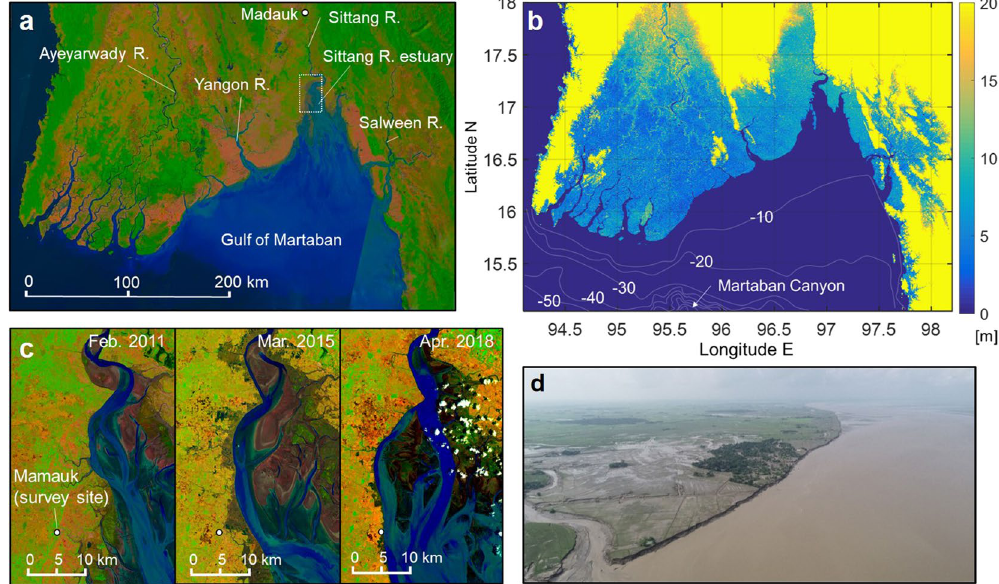
Figure 1. Sittang River estuary at head of Gulf of Martaban. ( a ) Map of study area on Landsat satellite image. ( b ) Topographic/Bathymetric map of study area based on Shuttle Radar Topography Mission (SRTM 1 Arc- Second Global elevation data courtesy of the U.S. Geological Survey, https://lta.cr.usgs.gov/SRTM1Arc) and General Bathymetric Chart of the Oceans data (The GEBCO Digital Atlas published by the British Oceanographic Data Centre on behalf of IOC and IHO, 2003). ( c ) Rapid bank erosion on west side of Sittang River estuary. Peak erosion rate reached as high as 3 km/yr. These images were created from Landsat imagery. ( d ) Aerial photograph of survey site on September 17 th , 2018. Tree-planted areas are small villages of rice farmers, and one in centre, Mamauk, was being abandoned due to severe erosion at time of survey. Landsat imagery courtesy of NASA Goddard Space Flight Center and U.S. Geological Survey. Maps were created using MATLAB ver. R2006 from Mathworks Inc. Figure labels were added using Microsoft Powerpoint